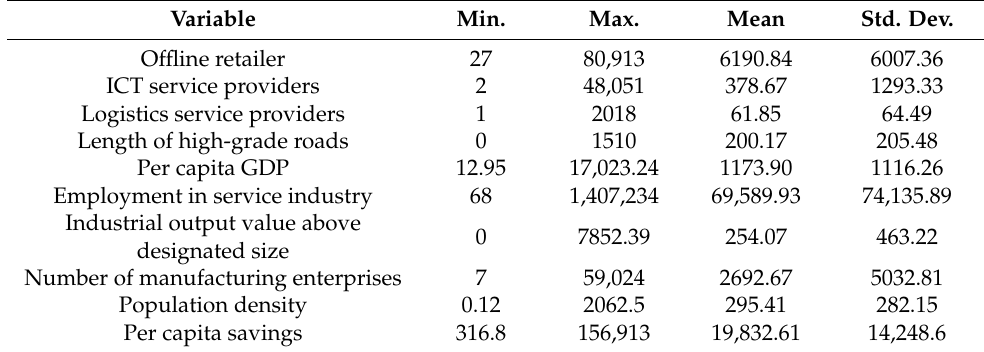
Table 1. Descriptive statistics.